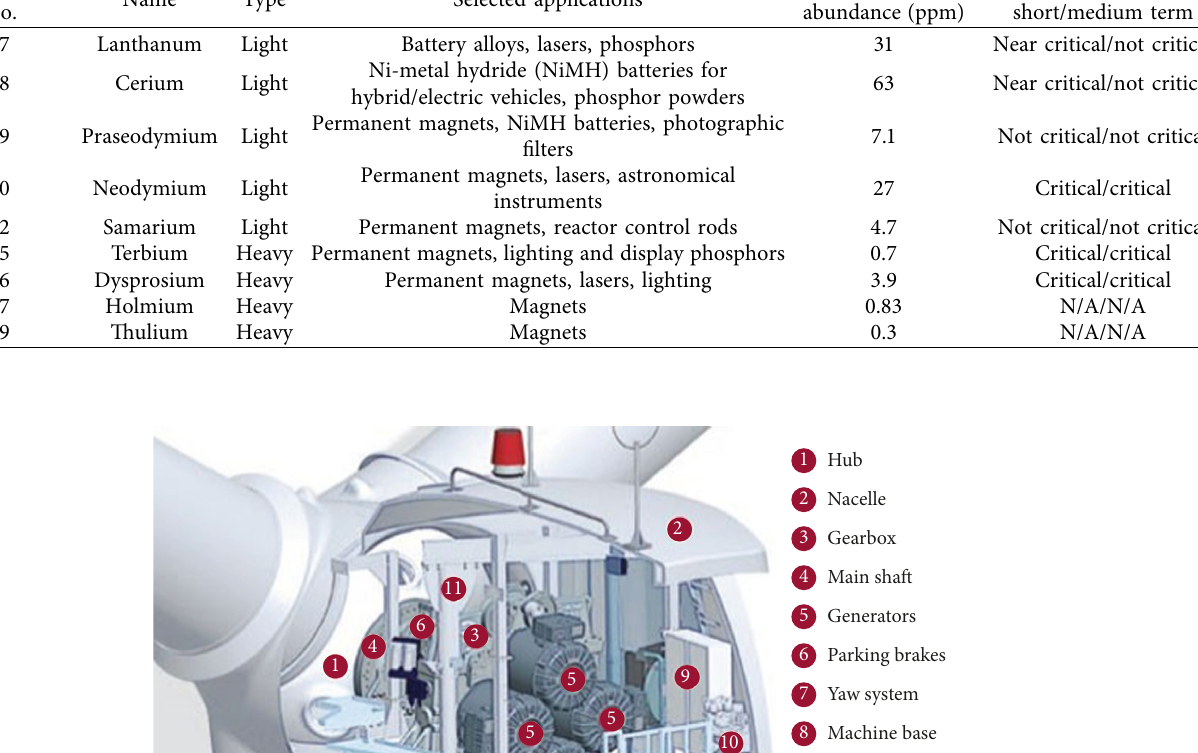
Table 1: A summary of selected rare-earth elements, applications, and criticality to clean energy [2]. Atomic